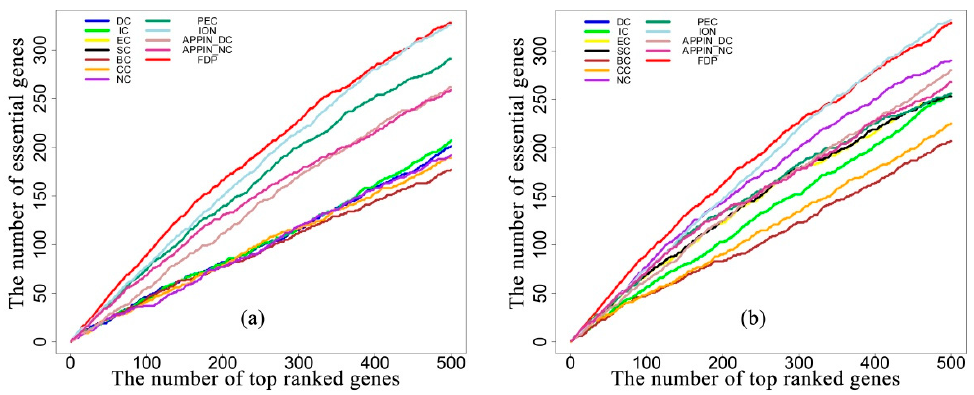
Figure 4. Jackknife curves of the FDP and other existing methods based on the DIP_PPI network ( a ) and the SC_net network ( b ).